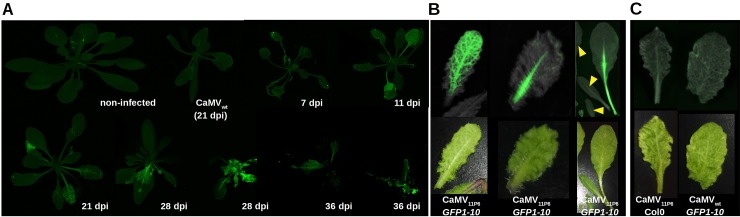
Visualization of 11P6 in CaMV11P6-infected A. thaliana GFP1-10 plants.(A) GFP1-10 plants were mechanically inoculated at different times with CaMV11P6 and analyzed at the indicated day post inoculation (dpi) for GFP fluorescence with a fluorescence scanner. The figure is a collage from different acquisitions and plants are presented at different magnification scales. Two plants are presented for 28 dpi and 36 dpi to show different infection states. Non-infected and CaMVwt-inoculated (21 dpi) plants are included as negative controls. (B) 11P6 fluorescence is observed before appearance of visual symptoms. Arabidopsis thaliana GFP1-10 plants were mechanically inoculated with CaMV11P6 and leaves analyzed at 24 dpi for GFP fluorescence and visual symptoms with a G:Box (upper panel). The leaves were also analyzed for symptoms with a color camera (lower panel). The three images present 11P6 fluorescence in symptomatic and unsymptomatic leaves. The various leaves in the image to the right are from the same plant. Note that the leaves indicated by the yellow arrowheads are not yet infected. (C) The two pictures show negative controls where either CaMV11P6 was inoculated in Col0 plants or CaMVwt in GFP1-10 plants as indicated. Images were acquired at 32 dpi with a G:Box or a color camera as described above.